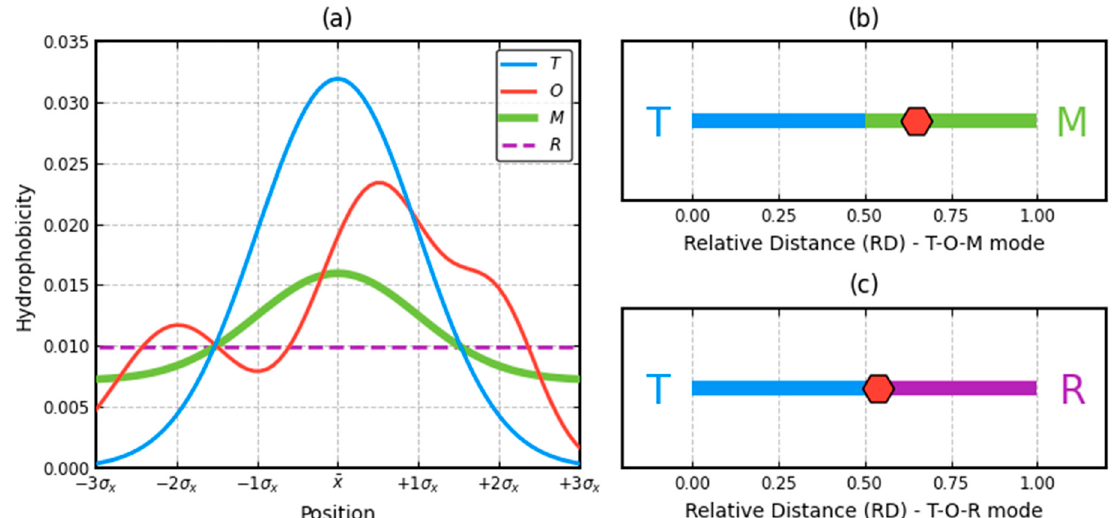
Figure 3. Analysis of examples (reduced to one-dimensional simplified version) of distribution ( a ) O (red) in respect to theoretical ( T —blue) and membrane influence distribution (M—green) and the reference distribution R (violet dashed). Values of RD (relative distance) for (T-O-M) = 0.651 ( b ) and for (T-O-R) = 0.539 ( c ).